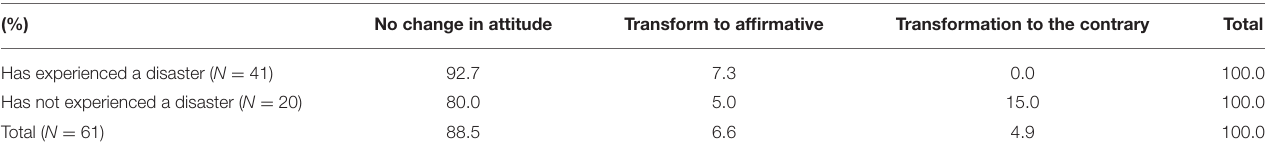
TABLE 8 | Changes before and after deliberations regarding the pros and cons of adaptation policies that local governments can take by having experienced a disaster (implementation of disaster prevention education and health maintenance activities in local communities).